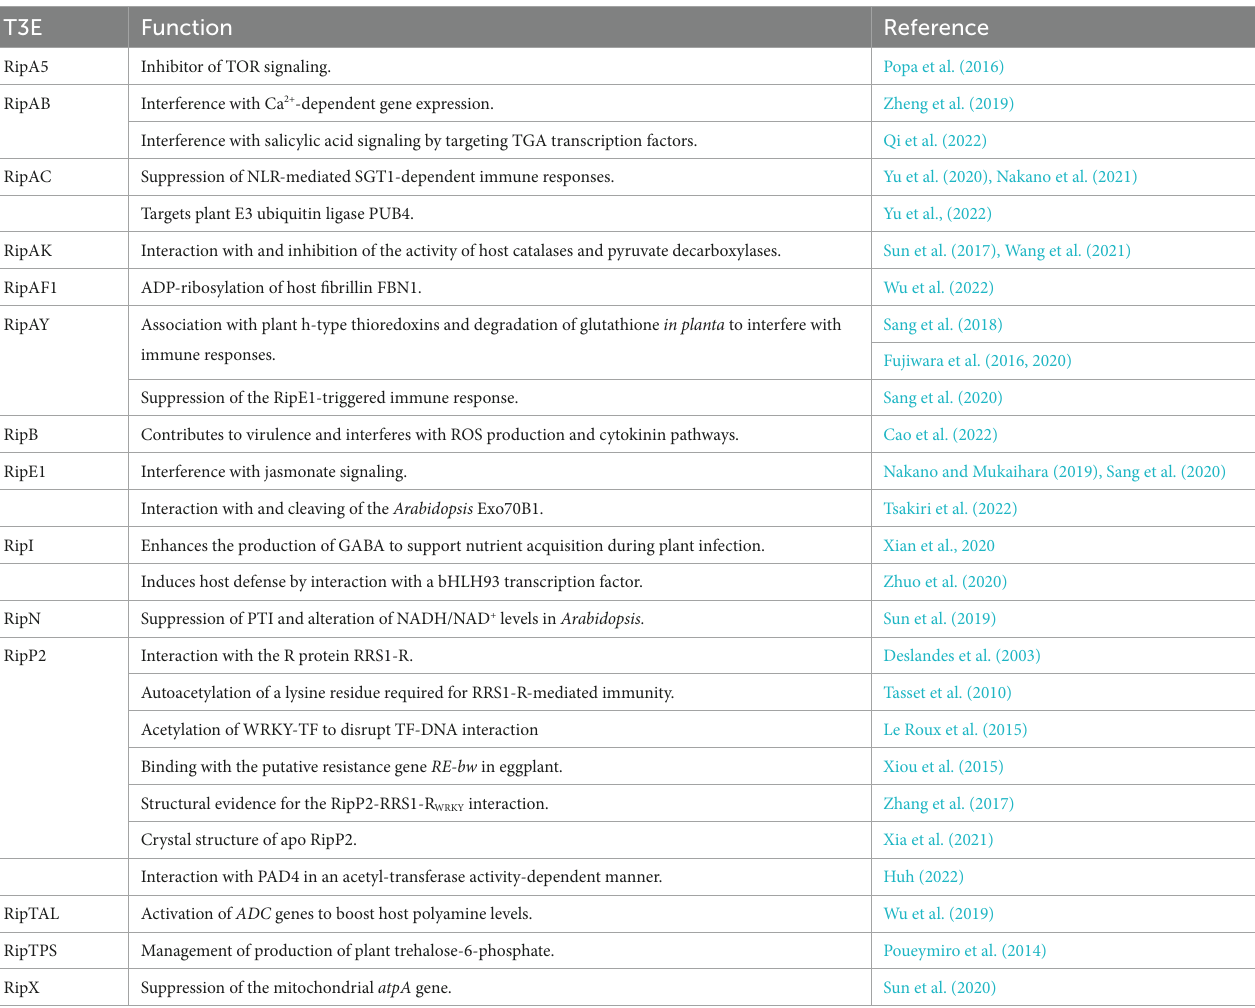
TABLE 2 Known functions of T3Es from the Ralstonia solanacearum species